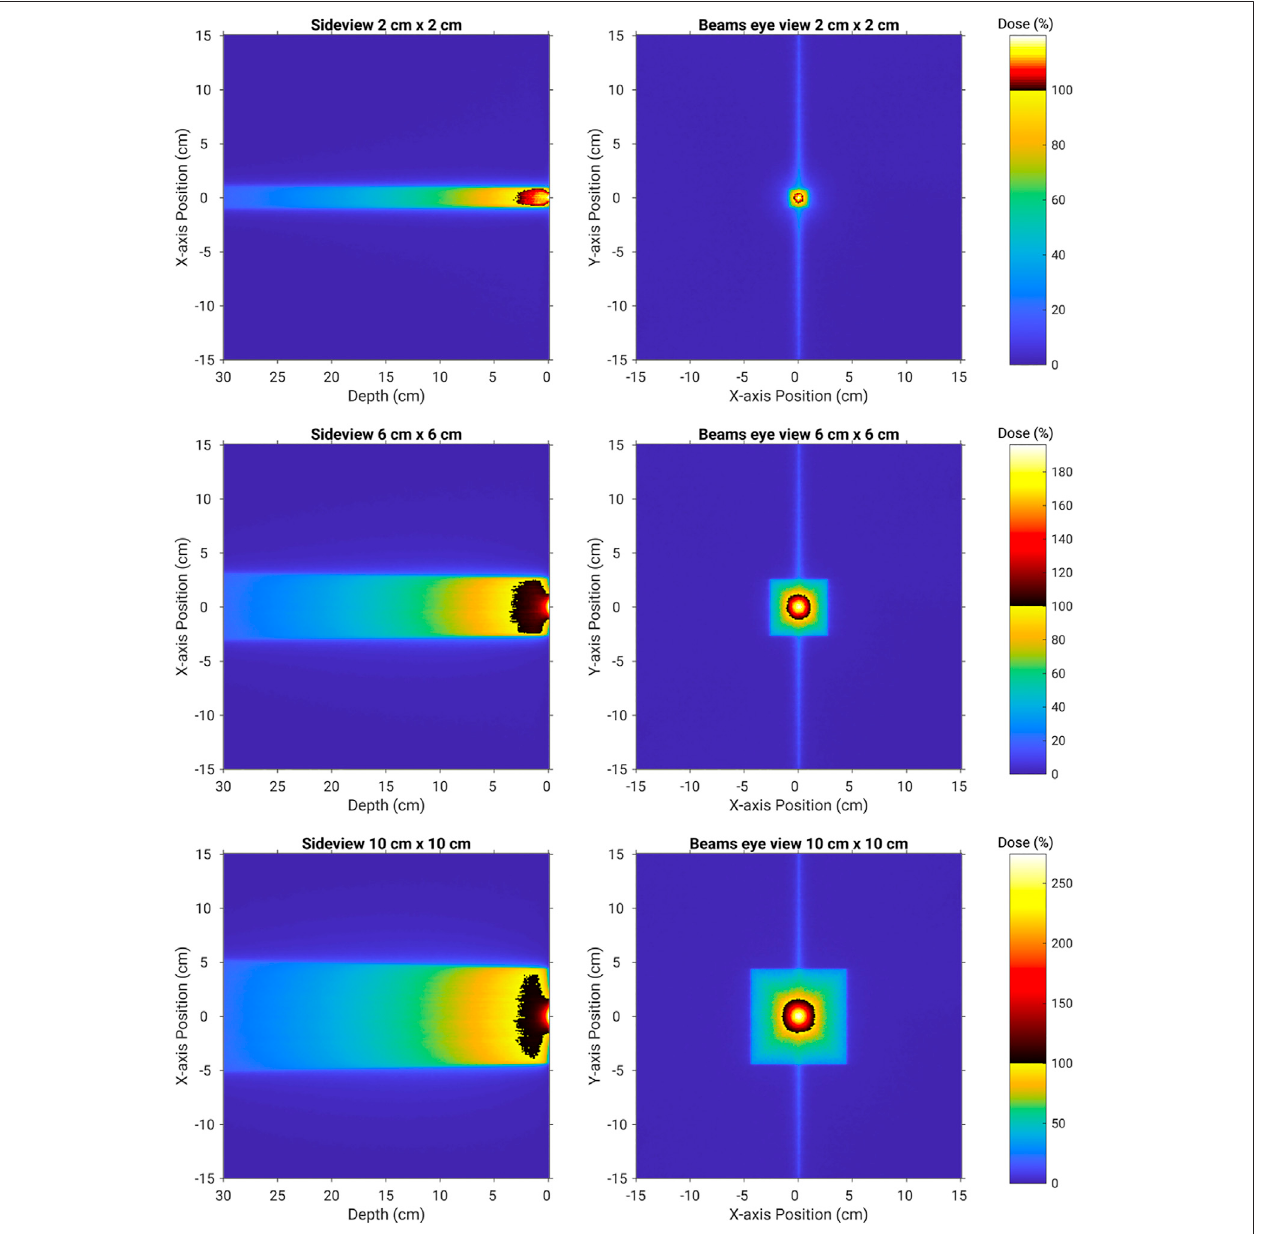
FIGURE2| 2Ddosemapsthroughandonthesurfaceofthewaterphantomfor fi eldsizesof2 cm×2 cm(toprow),6 cm×6 cm(middlerow),and10 cm×10 cm (bottom row). Doses greater than 100% of the nominal D max dose are presented through a second colormap. This clearly highlights the extent of the electron contamination